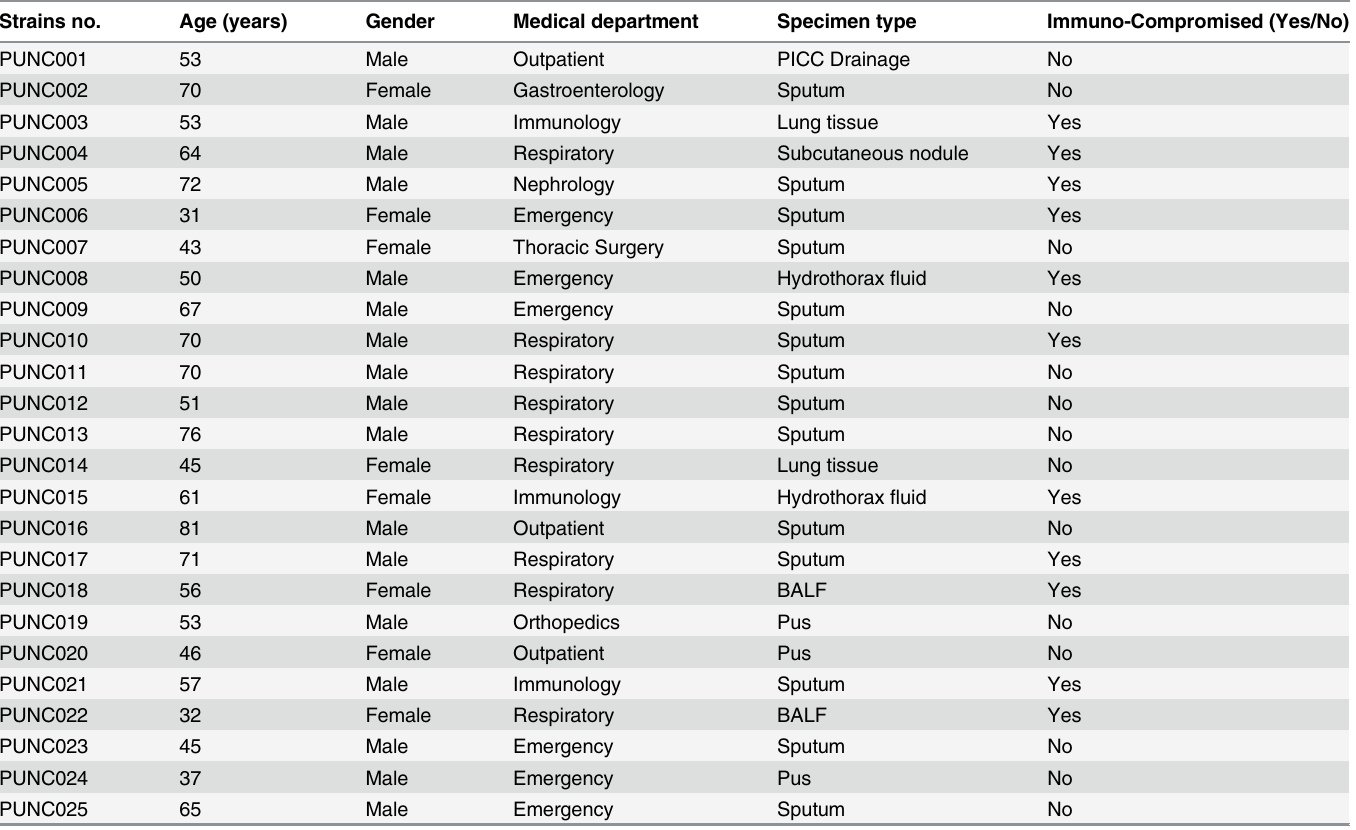
Abbreviations: PICC, peripherally inserted central catheter; BALF, bronchoalveolar lavage fl uid; SLE, systemic lupus erythematosus; COPD, chronic obstructive pulmonary